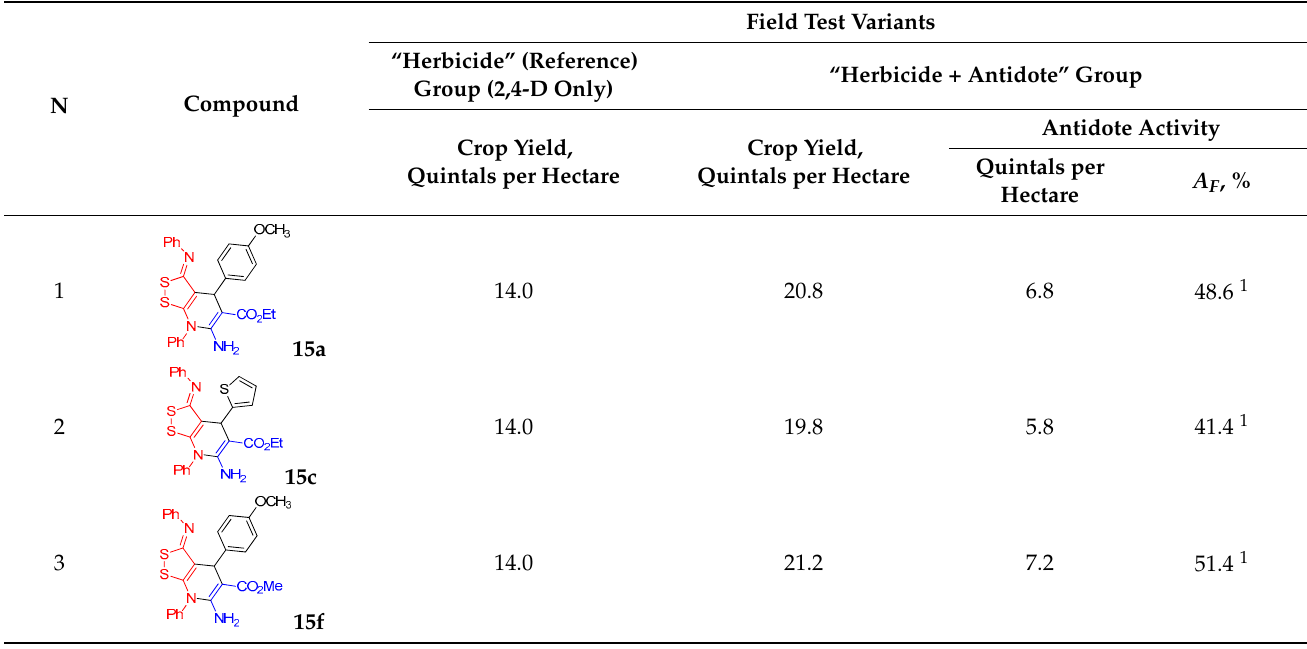
Table 2. Results of field tests on the antidote activity of 3H-[1,2]dithiolo[3,4-b]pyridines 15a,c,f against the herbicide 2,4-D on sunflower cv. Master. against the herbicide 2,4 ‐ D on sunflower cv. Master.